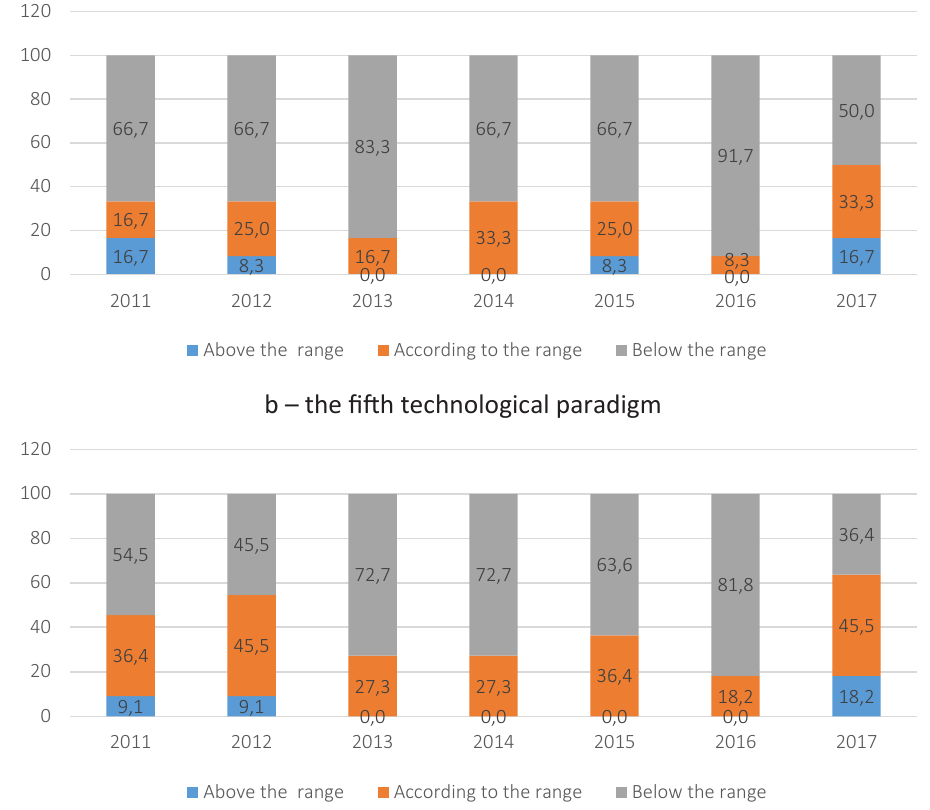
– the fourth Figure 5. Distribution of machine-building enterprises by the level of financial system dynamic development in terms of project implementation effects,